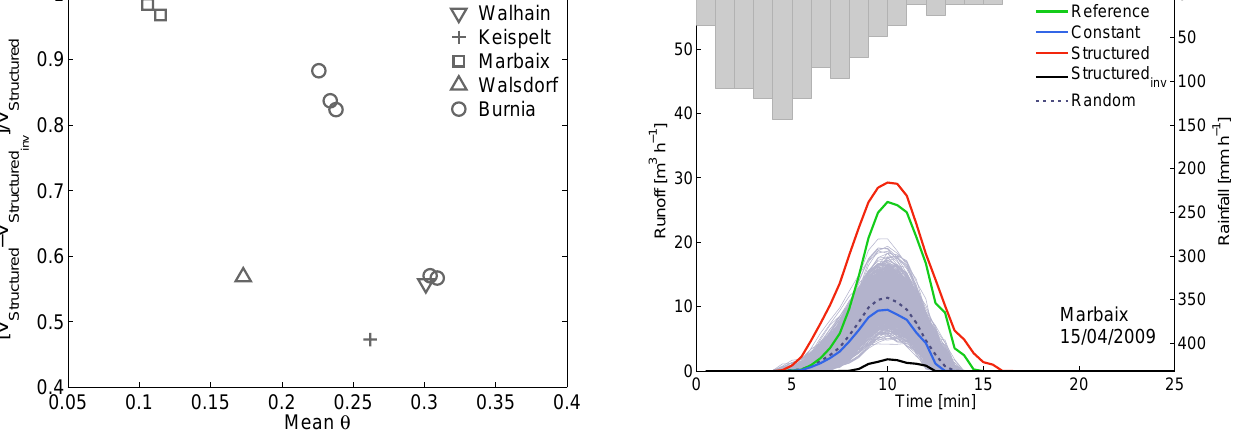
Fig. 5. Relative difference between Structured and Structured inv runoff volume as a function of the mean soil moisture in the field.